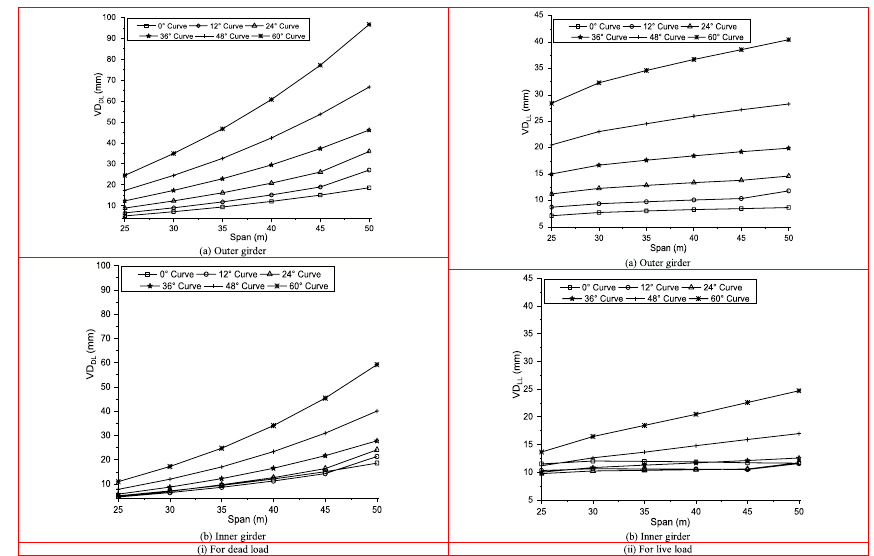
Fig. 16 Variation of vertical deflection with span for different curve angle. a Outer girder. b Inner girder. (i) For dead load. (ii) For live